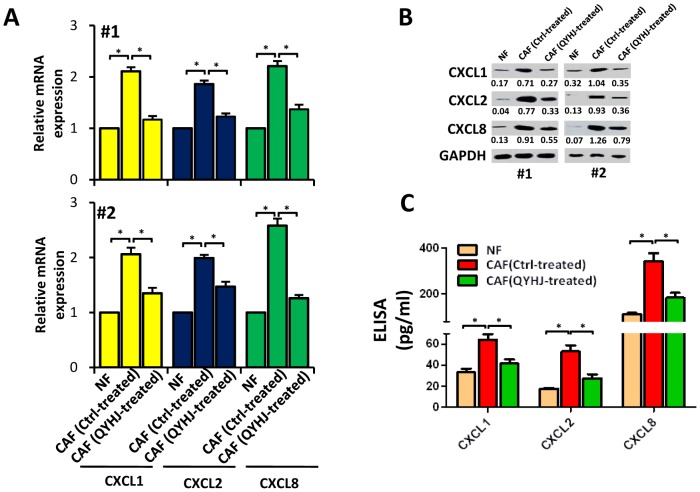
QYHJ suppressed CXCL production in CAFs.A–B. CAFs were treated with QYHJ-Containing Serum or Control-Containing Serum for 48 h. The cells were then harvested, and the expression of CXCL1, 2 and 8 was evaluated using real-time PCR (A) and western blotting (B). C. The isolated CAFs were plated in T25 flasks (1 × 106 cells) and cultured in DMEM containing 10% QYHJ-Containing Serum or Control-Containing Serum. Twenty-four hours later, the media were removed, and the cells were washed twice with PBS. The cells were subsequently incubated with 5 ml of fresh DMEM medium for an additional 48 hours. The medium was subsequently harvested, and the CXCL1, 2 and 8 concentrations were detected through ELISA. ANOVA was used to determine the statistical significance. * P<0.05.